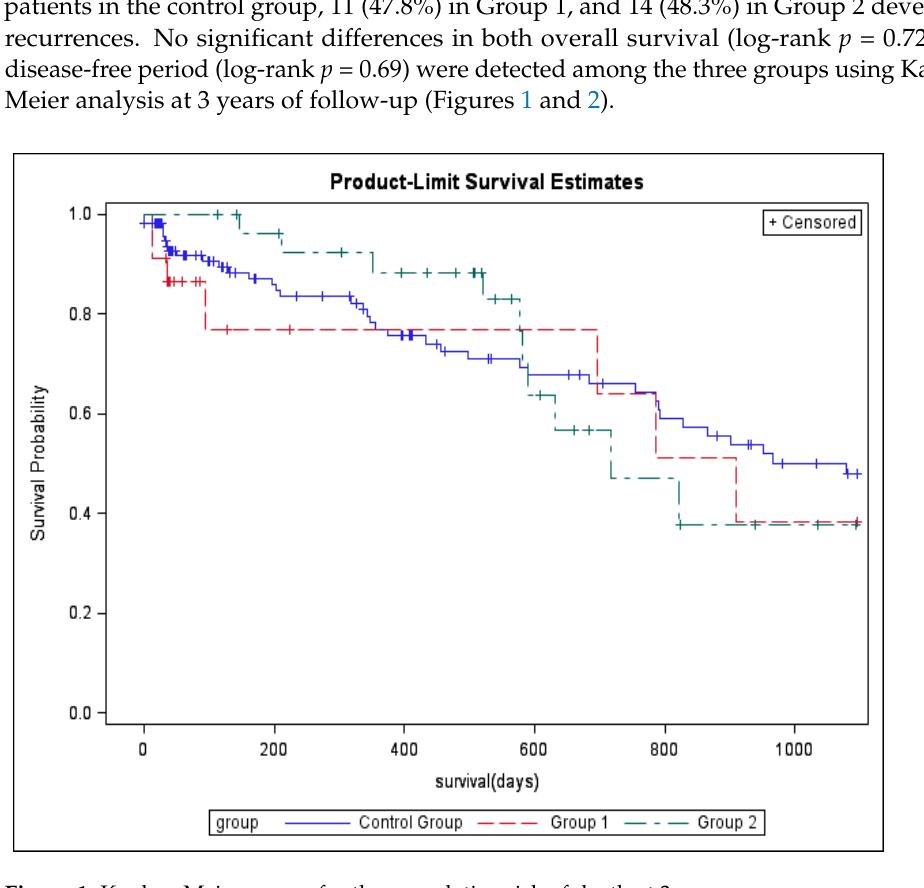
Figure 1. Kaplan–Meier curves for the cumulative risk of death at 3 years. Overall, SL was detected in 31 of 172 (18.0%) subjects undergoing CLND. Upper-limb lymphedema after axillary dissection is less frequent than lower-limb lymphedema after groin dissection (10.0% vs. 23.5%, Chi-square p = 0.02). Considering body mass index (BMI), we detected 31 (18.0%) obese subjects; there was an insignificantly ( p = 0.09) higher frequency of obesity among subjects who developed lymphedema (29.6%) than in the rest of the population (15.8%). The use of PMLVA led to a significant reduction in secondary lymphedema in both Group 1 ( p = 0.03) and in Group 2 ( p = 0.01) when compared with subjects included in the control group. In fact, frequency of SL was 24.2% (29 of 120 subjects) in the control group, 4.3% (1 of 23) in Group 1, and 3.5% (1 of 29) in Group 2.